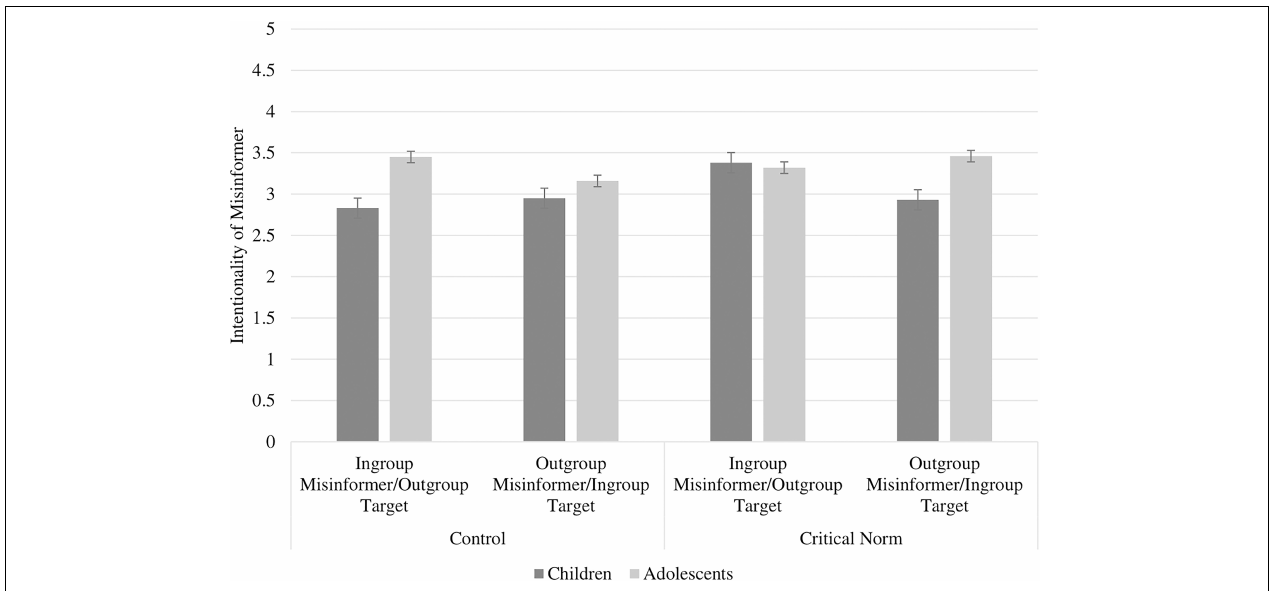
FIGURE 1 | Participants’ intentionally attributions (1 = Definitely not OK intentions, 5 = Definitely OK intentions) of the misinformer by age group, ingroup norm, and group membership (with standard errors